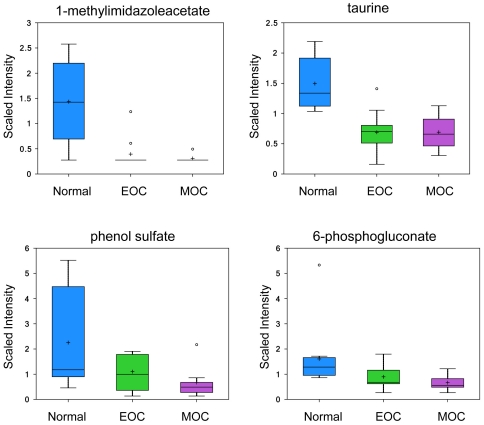
Significant metabolites present in the normal ovary and are reduced upon neoplastic transformation.1-methylimidazoleacetate and taurine analyzed by LC/MS positive ion spray; phenol sulfate and 6-phosphogluconate analyzed by LC/MS negative ion spray. Box legend: + inside box represents mean value, bar inside box represents median value, upper bar represents maximum of distribution, lower bar represents minimum of distribution, circle represents extreme data points.